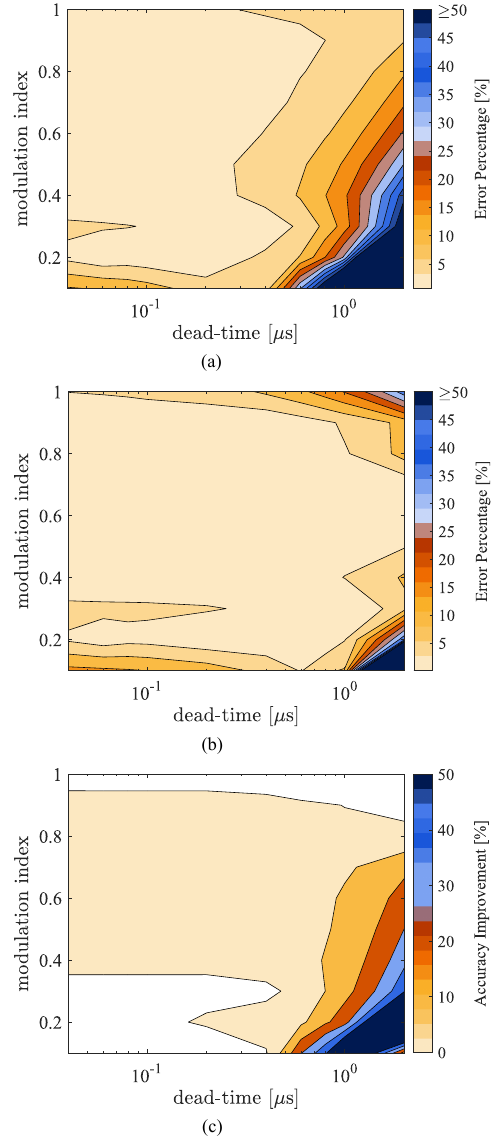
Figure 16. Absolute error percentage of the ( a ) benchmark and ( b ) proposed equations; ( c ) relative improvement of the proposed equations compared to the benchmark equations (case 1 load,